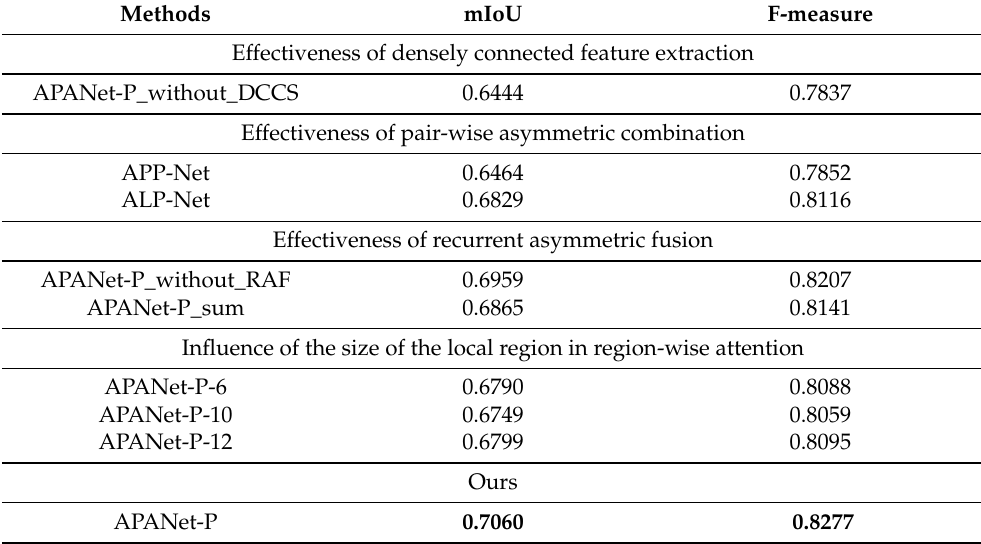
Table 5. Model ablation analysis on SIRST